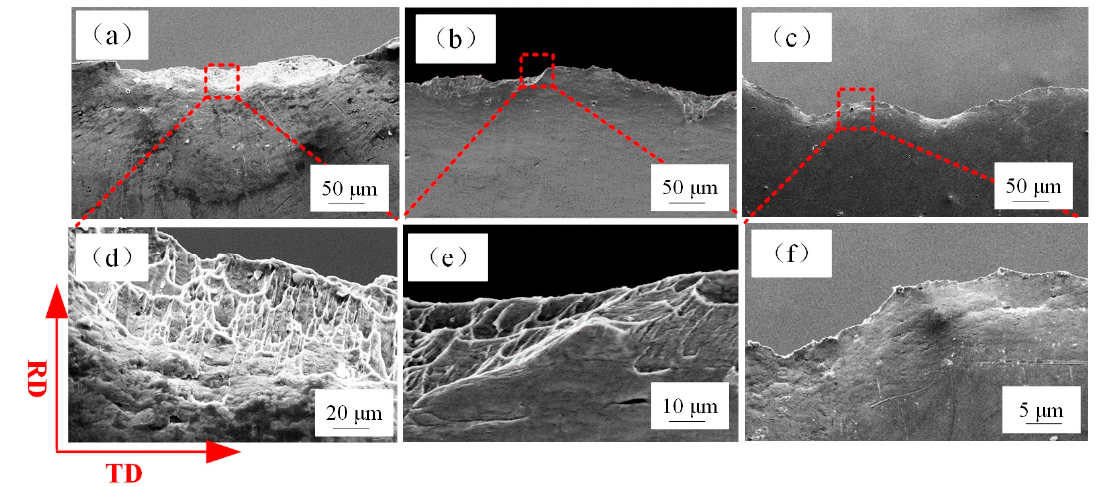
Figure 6. SEM fractographs of foil samples with thicknesses of ( a ) 80 µ m ( b ) 40 µ m, and ( c ) 20 µ m, where ( d ), ( e ), ( f ) are an enlarged view of the dotted rectangle in (a), (b), (c).